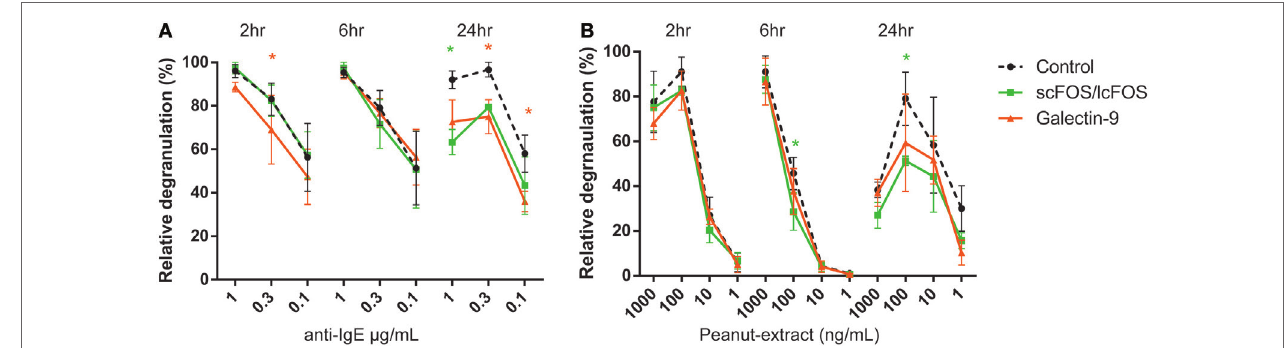
FigUre 1 | Time-dependent kinetics of non-digestible oligosaccharides or galectin-9 on anti-IgE or CPE induced basophil degranulation of a representative donor. Blood of peanut-allergic patients ( n = 3) was pre-incubated for three different time-periods with short- and long-chain fructo-oligosaccharides (scFOS/lcFOS) or 1 µg/mL galectin-9 either in the aspecific (a) or peanut-specific (B) basophil activation test. Data represent n = 3 peanut-allergic patients. Significance is indicated compared to the control sample. * P < 0.05 by two-way ANOVA. Green: control compared to scFOS/lcFOS, orange: control compared to